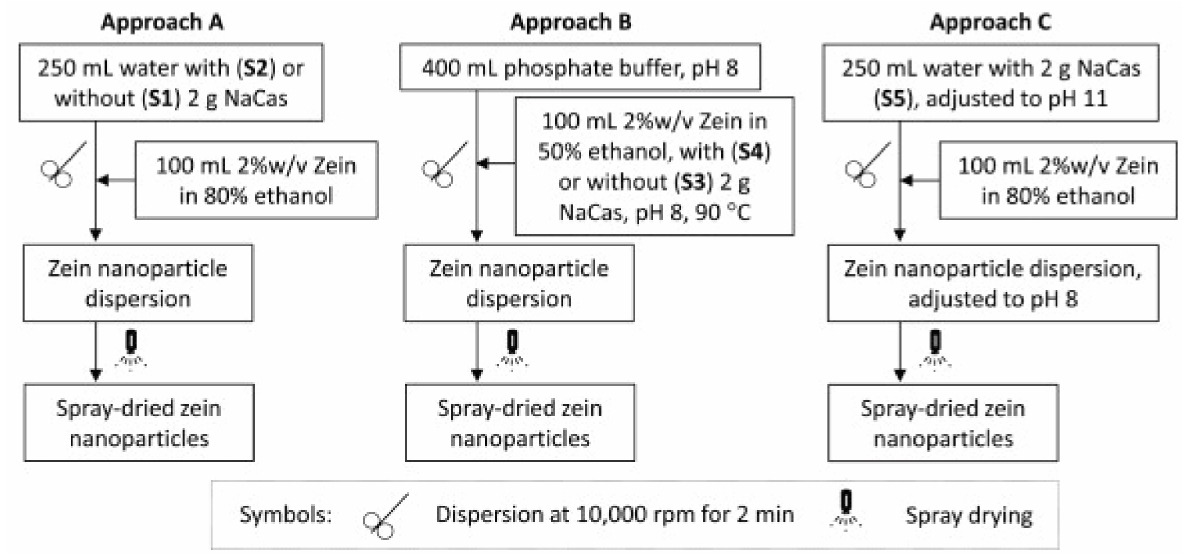
Figure 2. Three different approaches used to prepare zein nanoparticles through spray drying. Reprinted with permission from ref. [15]. Copyright 2014